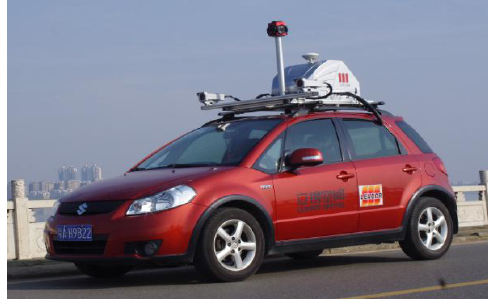
Figure 6. The mobile measure car